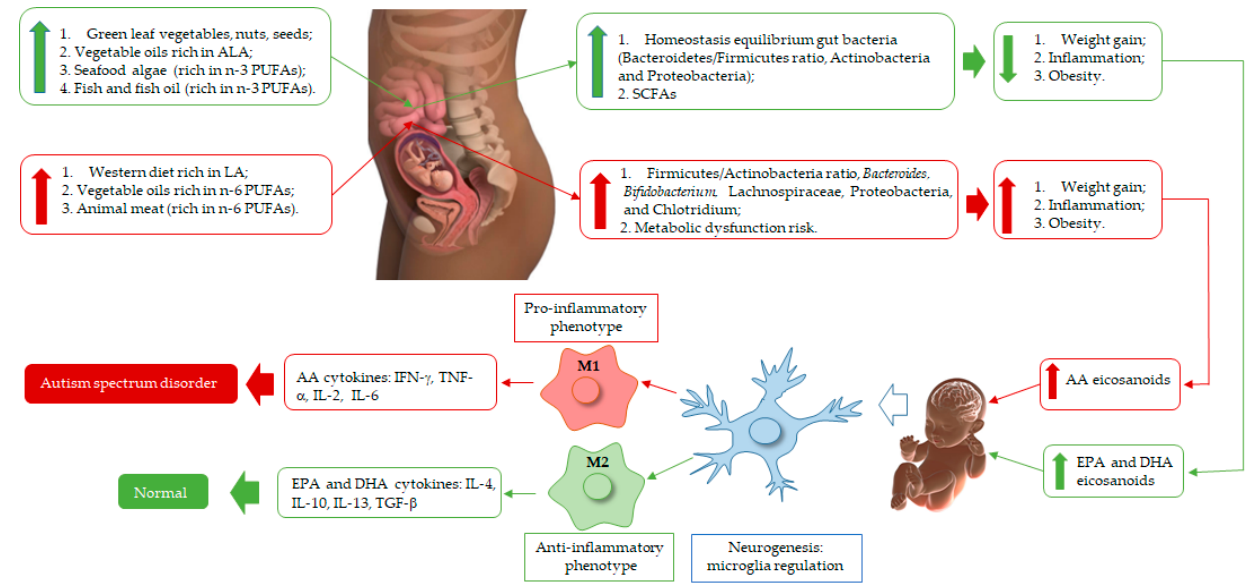
Figure 1. Schematic representation of n-3 and n-6 polyunsaturated fatty acids (PUFAs) rich diet of pregnant woman, fetus, and neonate brain development. EPA and DHA produce eicosanoids (resolvins, protectins) with anti-inflammatory effects and modulate the membrane patterns of lymphocytes, macrophages, and neutrophils, decreasing AA content. These biosynthesis events are correlated with macrophage 2 (M2) action and equilibrium homeostasis conditions in fetus and baby brain health during its development, and their eicosanoids inhibit or slow down arachidonic acid (AA), which acts as an anti-inflammatory agent for neurogenesis health improvement. On the other hand, vegetable oils and animal meat (poultry, beef, pig) are rich in linoleic acid (LA). Thus, in the body, LA is bio-converted to AA, which is correlated with eicosanoid production (prostaglandins (PGs), leukotrienes (LTs), and lipoxins (LXs)), linked to molecule signaling in the oxidative pathway of AA and macrophage 1 (M1) recruitment, correlated with pro-inflammatory processes, which damage the microglia, affecting normal brain regulation and development, which then may lead to Autism Spectrum Disorder. These regulation processes begin when a woman is pregnant (fetus) until the breastfeeding of her baby. Thus, infant neurogenesis health is governed by the type of PUFA and eicosanoid components accumulated in the brain, linked to maternal diet.